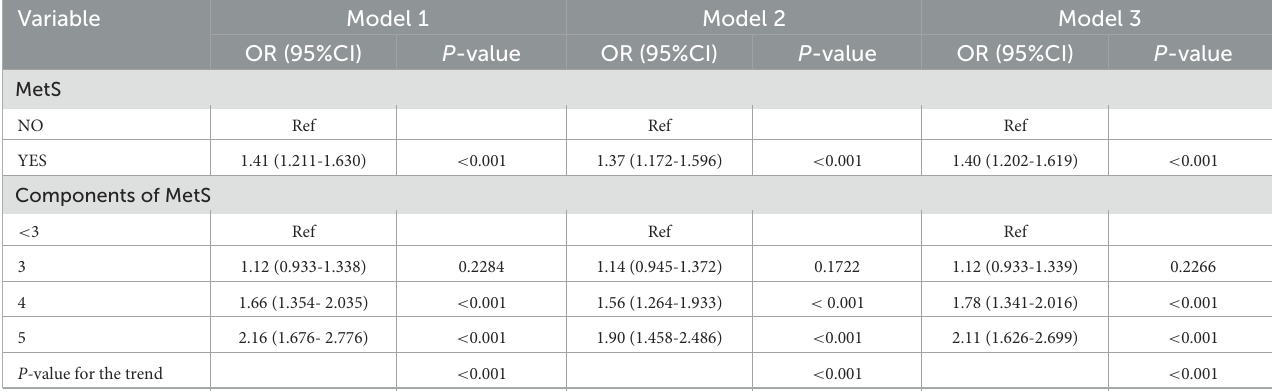
TABLE 2 Adjusted odds ratios for the prevalence of depression according to the presence of metabolic syndrome and its components in the PS-matched cohort.